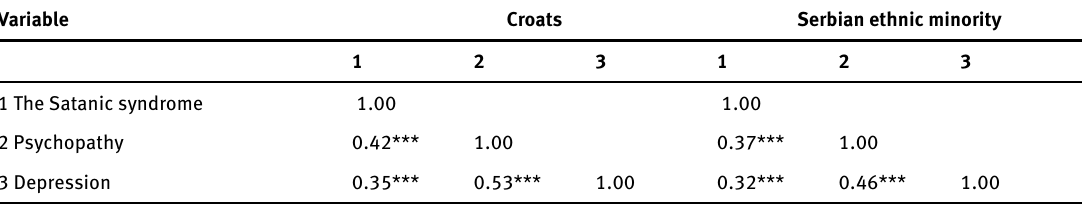
Table 5. Correlations among the Satanic syndrome, psychopathy, and depression within different ethnic groups Variable Croats